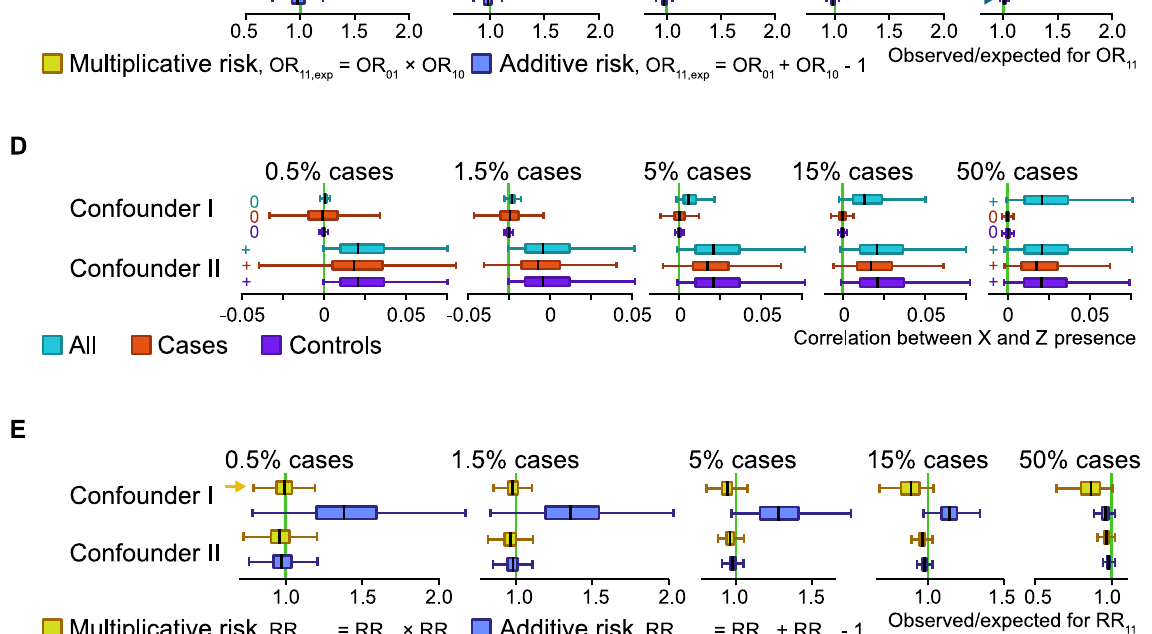
PLOS ONE | https://doi.org/10.1371/journal.pone.0250282 April 26, 2021 7 /